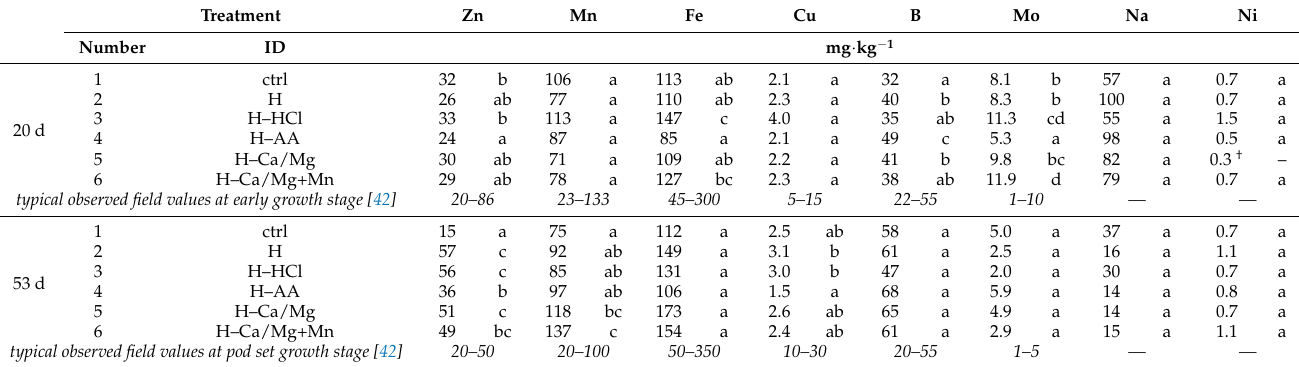
Table 7. Soybean shoot micronutrient and sodium concentrations at 20 (growth stage V4–V6) and 53 (growth stage (R1–R2) d after planting for a hydroponic nutrition